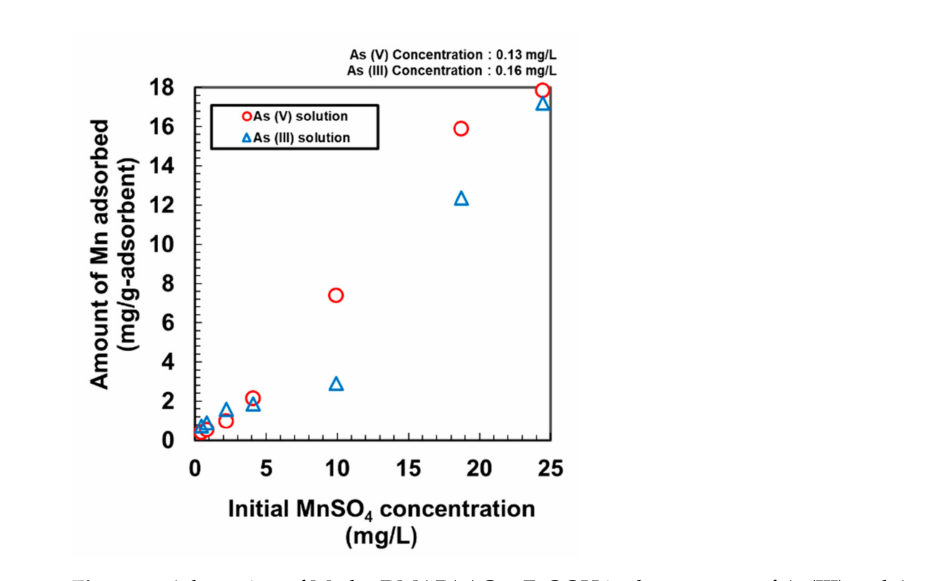
Figure 3. Adsorption of Mn by DMAPAAQ + FeOOH in the presence of As(III) and As(V) solutions.